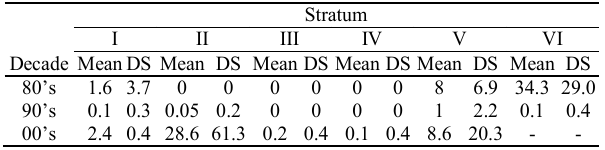
Table 1. Mean number of individuals per haul recorded in each stratum during surveys. Surveys carried out in the 1980’s: REDE 1986 and Gallo 1986; surveys carried out in the 1990’s: REDE 1995 and 1996; surveys carried out in the 2000’s: REDEs 2004 to